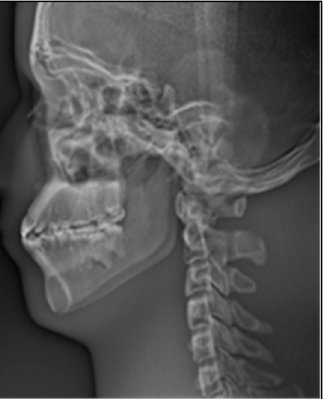
Figure 17. Lateral cephalogram after reverse color